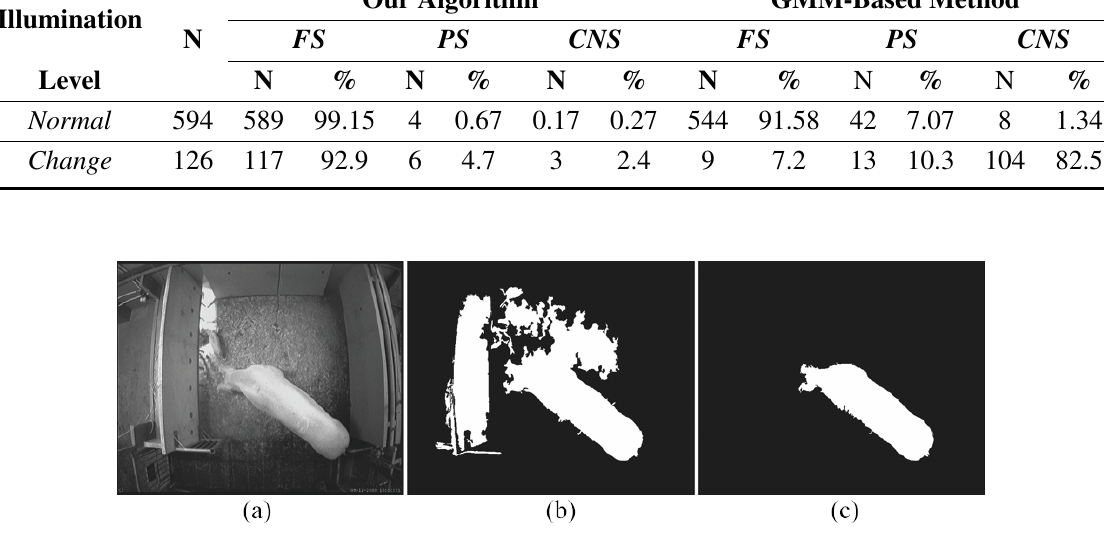
Figure 8. Sudden illumination changes: ( a ) the original image; ( b ) the segmented result based on the GMM model; ( c ) the segmented result by using our algorithm. The example shows that the Gaussian mixture model (GMM)-based method fails under sudden light